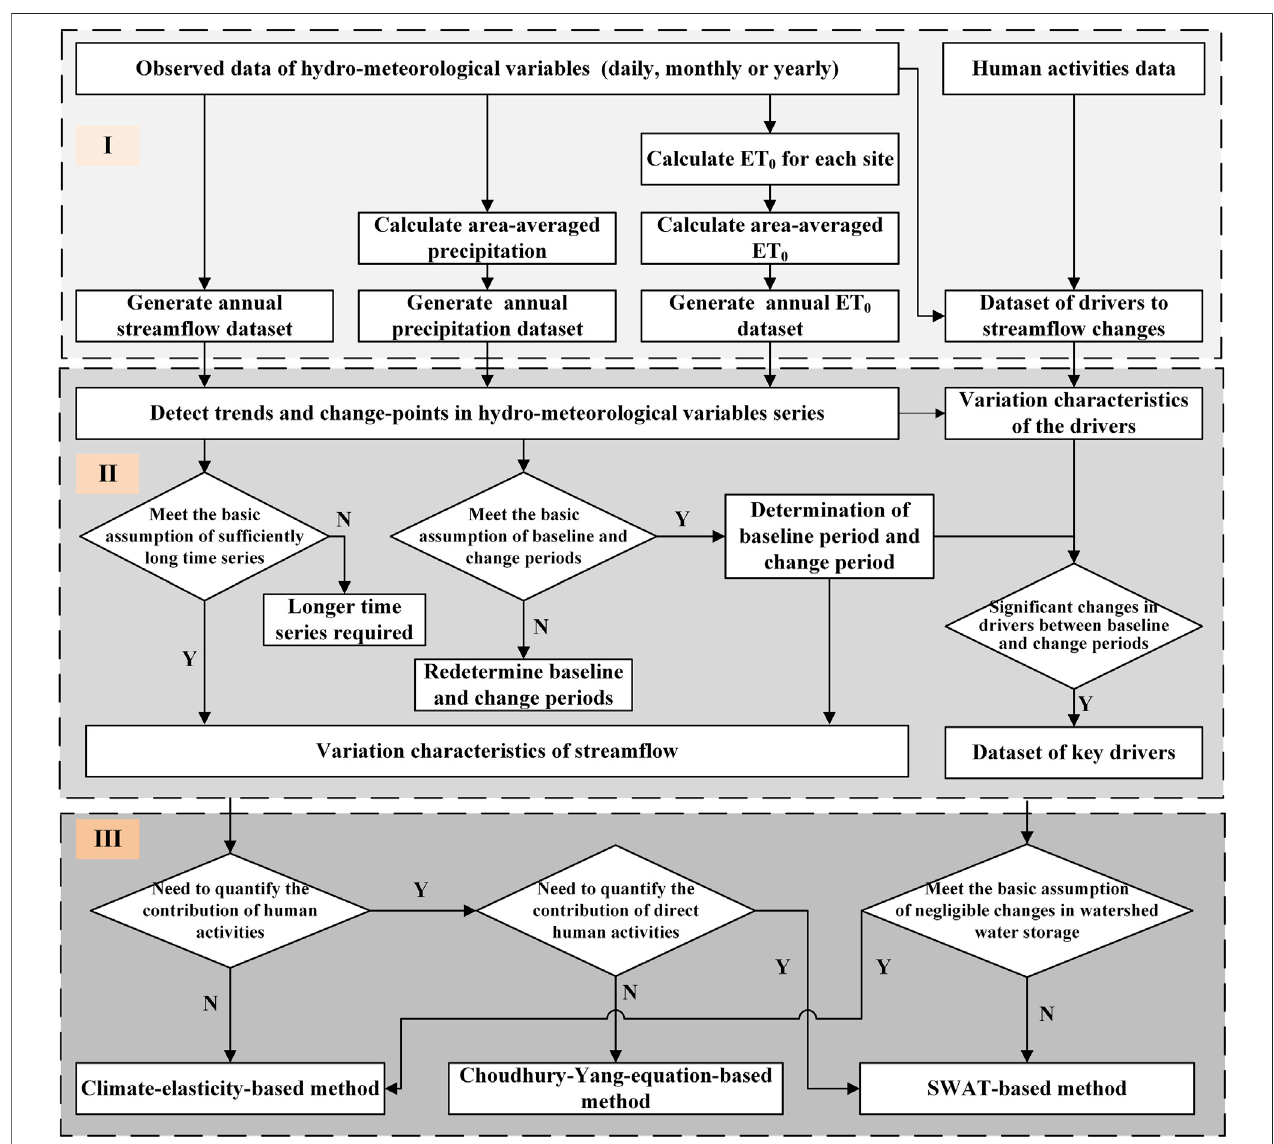
FIGURE 1 | Flowchart of the framework for methodological options to assess climatic and anthropogenic in fl uences on stream fl ow.